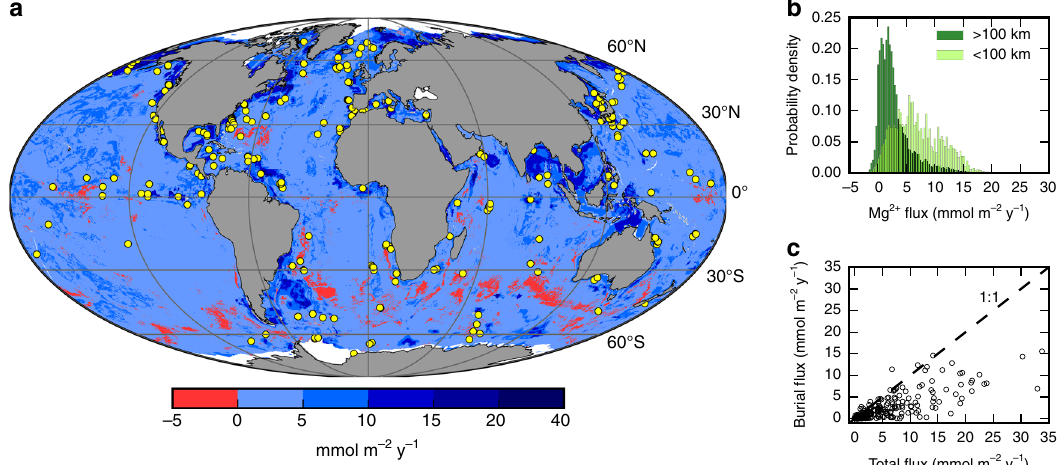
Fig. 1 Global magnesium fl uxes into marine sediments. a Global distribution of net magnesium fl uxes into marine sediments (millimoles per square meter per year); positive values are from the ocean into the sea fl oor; dots are the individual ocean drilling sites with measured fl uxes. b Histogram showing the distribution of net magnesium fl uxes near (<100 km, n = 396,962) and farther away (>100 km, n = 4,8811,049) from the continental margins. c Comparison of the magnitude of the net magnesium fl uxes ( n = 269) at each location versus the fl ux associated with pore water burial. Source data are provided as Source Data fi les